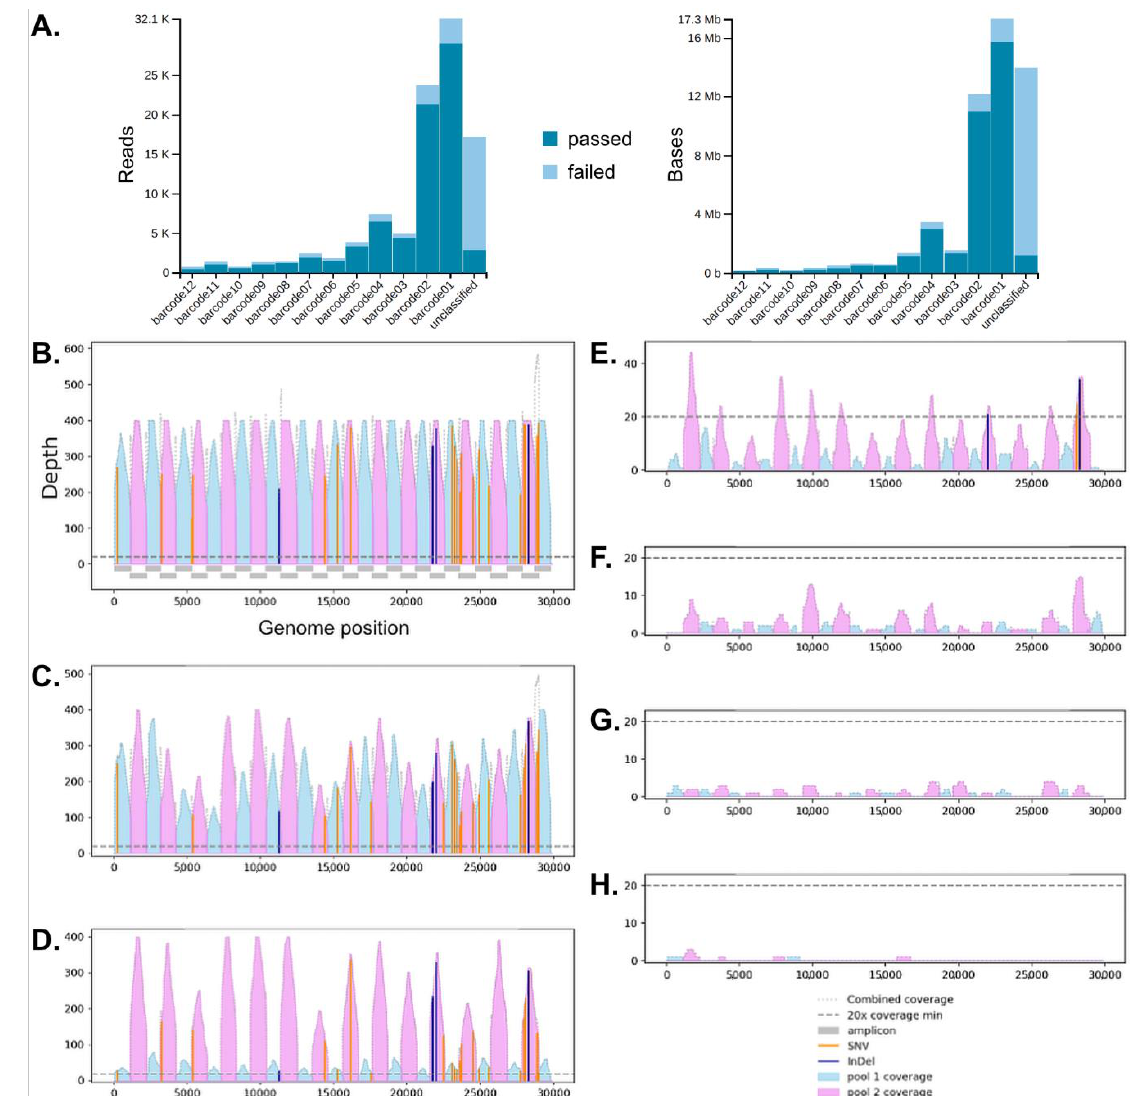
Figure 2. Surveillance using nanopore sequencing ( A ), and effects of specimens dilution on the SARS-CoV-2 genome coverage ( B ), whereby viral copy numbers were 1.28 × 10 6 ( B ); 5.12 × 10 8 ( C ); 2.56 × 10 8 ( D ); 4 × 10 6 ( E ); 2 × 10 6 ( F ); 1 × 10 6 ( G ); 5 × 10 5 ( H ). In ( A ) increasing barcode numbers ( X -axis) correspond to decreasing viral titers.